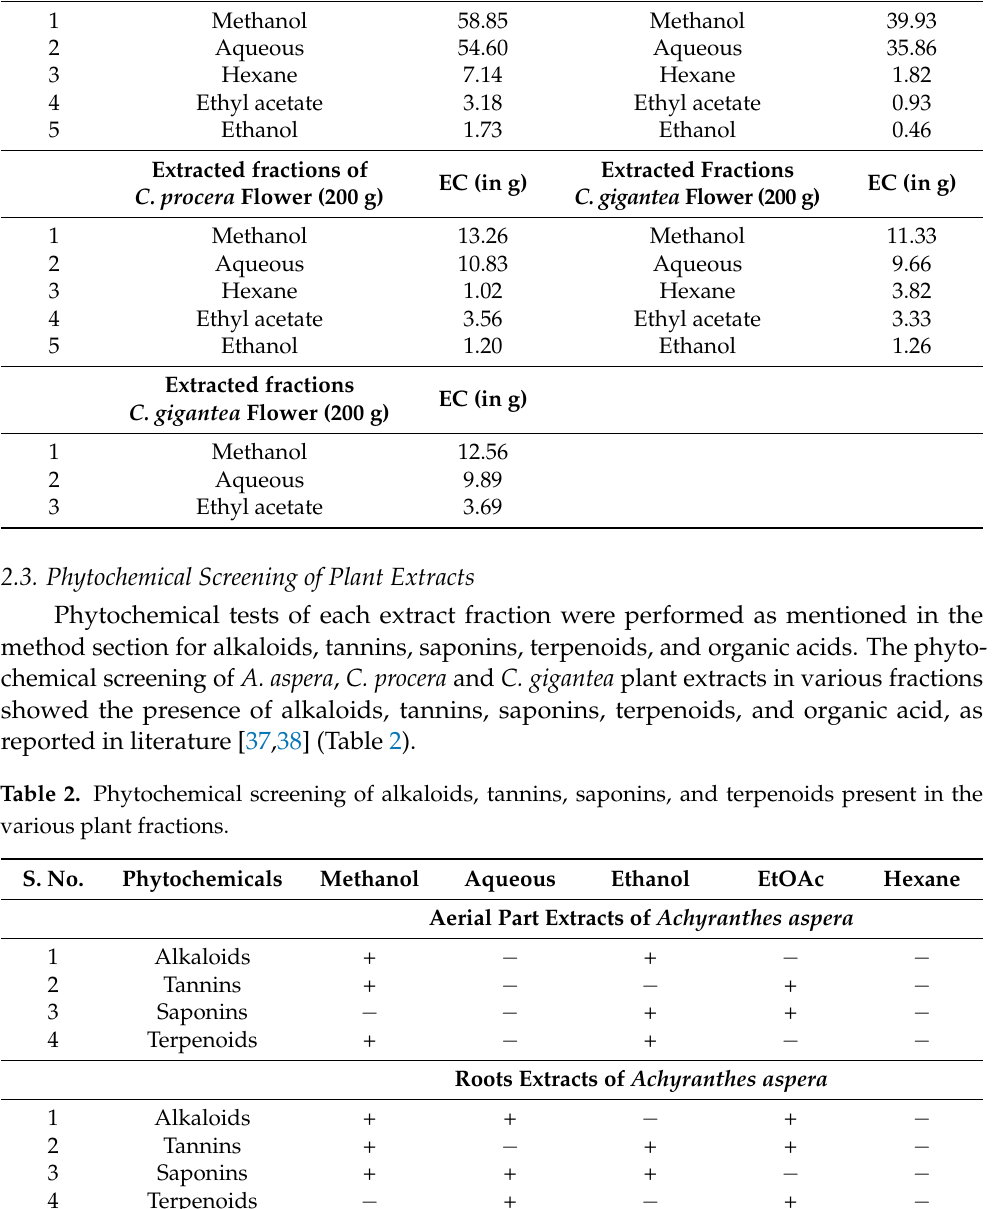
Table 1. Total yield of the extractable components (EC) from A. aspera (aerial and root parts) C. procera (flower), C. gigantea (flower) and C. gigantea (flower ash). S. No.